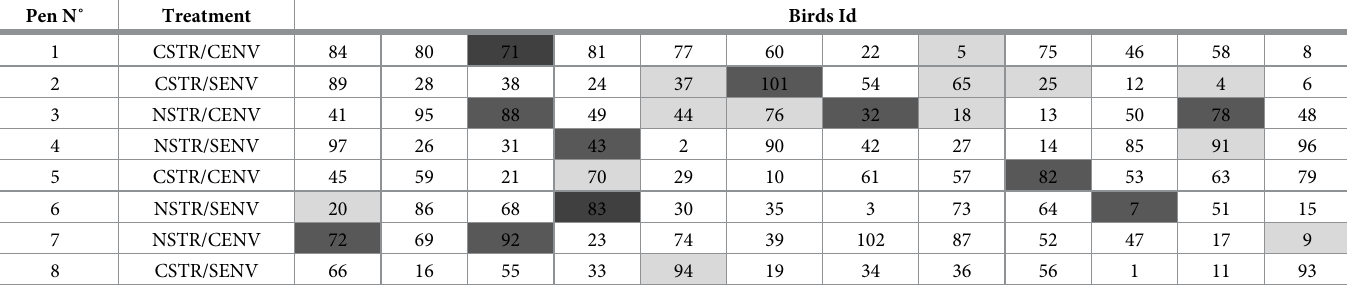
Table 1. Dead and euthanized birds after the injection of SRBC. The first column indicates the pen number; the second column indicates the corresponding treatment (CSTR/NSTR referring to the Cold Stress or No Stress treatments and SENV/CENV referring to the Simple or Complex Environments respectively); the last column lists the identity numbers of the birds in the pen; the birds that died are marked in dark grey and those that had to be euthanized are marked in light